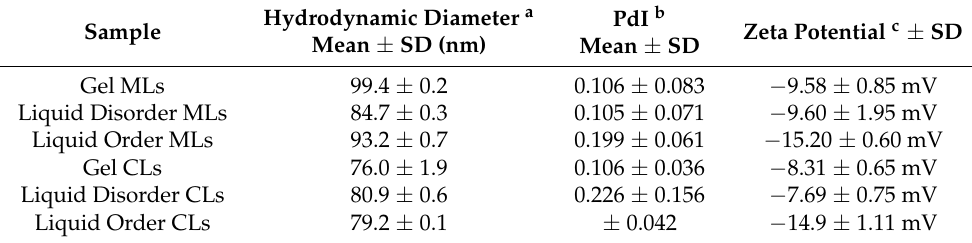
Table 1. Characterization results based on a intensity size distribution model, b polydispersity index, c zeta potential in HEPES buffer at pH =